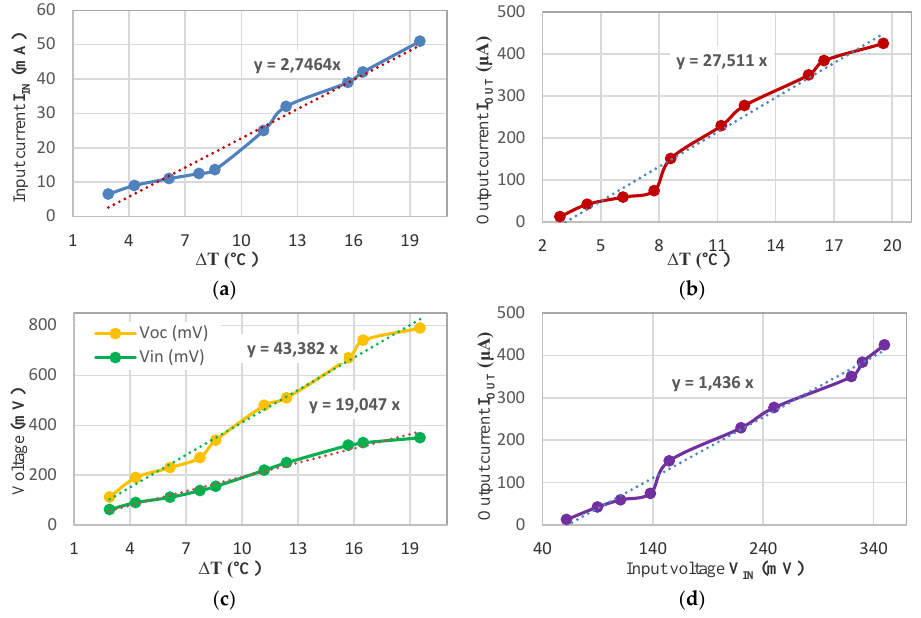
Figure 16. TMG-127-1.4-1.2 TEGs characterization: input current I IN ( a ), output current I OUT ( b ), open-circuit V OC and input V IN voltages ( c ) as function of ΔT, and output current I OUT as function of the input voltage V IN ( d ).